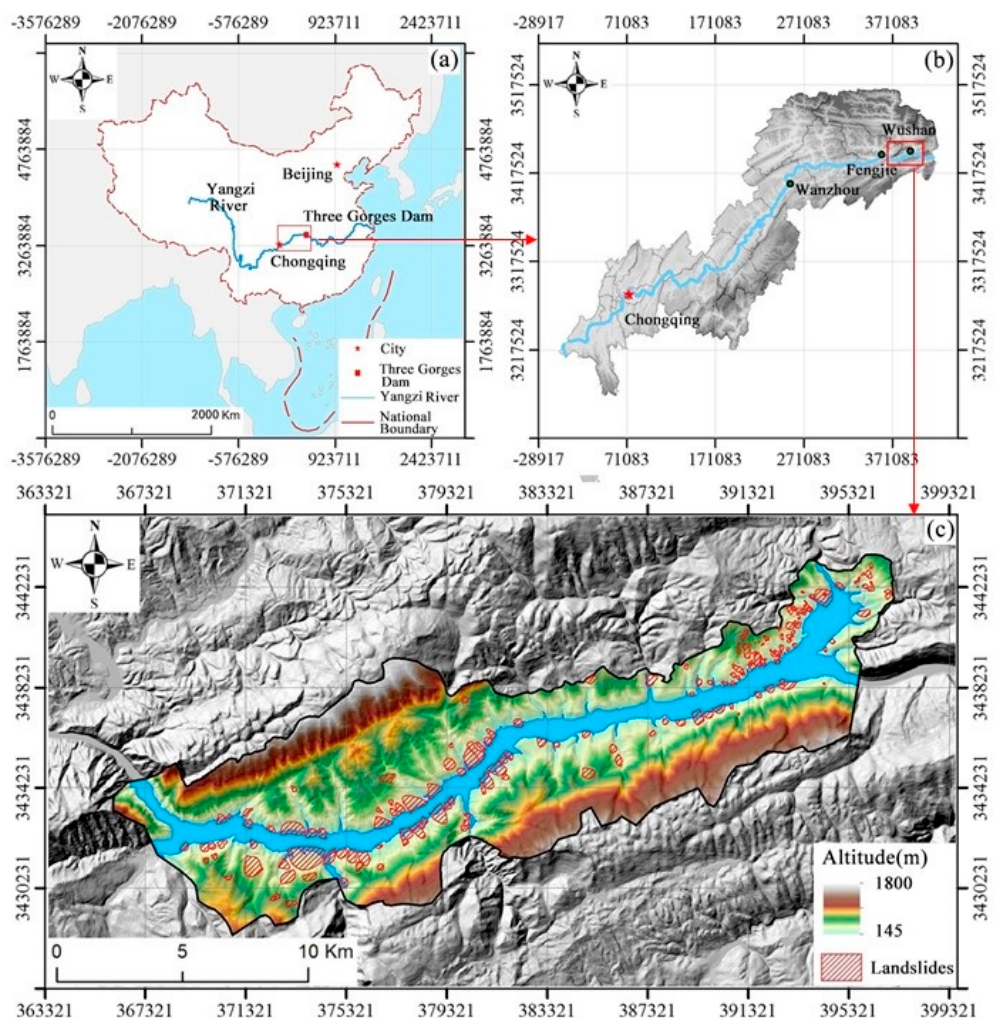
Figure 1. ( a ) The location of Three Gorges Reservoir area (TGRA) in China. ( b ) The location of the study area. ( c ) Elevation map of the study area with landslide distribution (the landslides polygons were obtained from historical landslide data, field investigation, and high-resolution remote sensing image data).